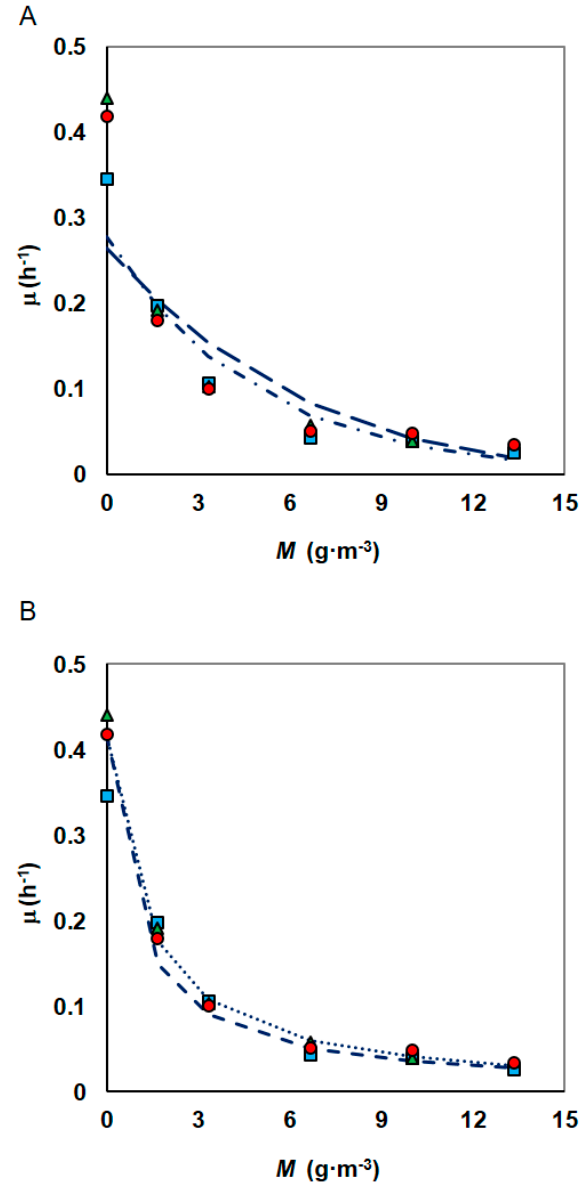
Figure 7. Inhibitory effect of increasing concentrations of nickel to the specific growth rate of S.maltophilia KB2 strain as fitted by the: ( A ) Han–Levenspiel and Kai models, ( B ) Andrews model